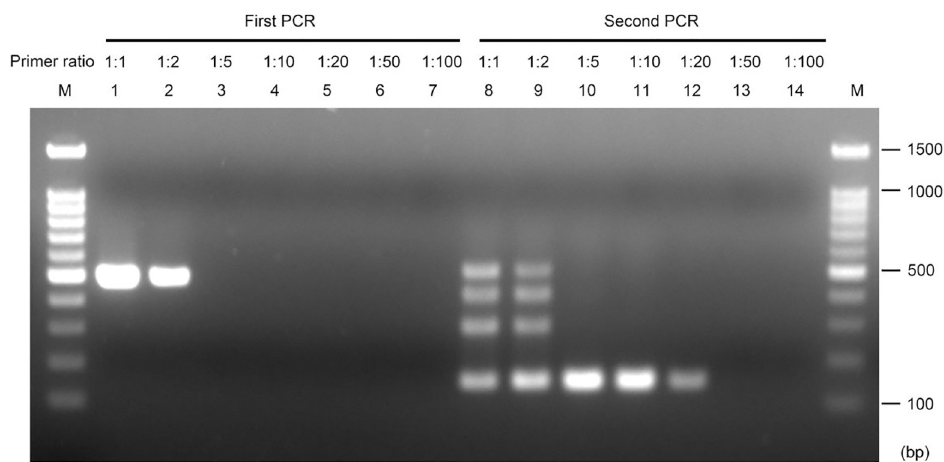
Fig 4. Optimization of the primer ratio for the nested PCR assay. Lanes 1–7, first PCR product; lanes 8–14, second PCR product. The nested PCR assay was performed using primers Col_nest-1F/Col_nest-1R for the first PCR, and Col_nest-2F/Col_nest-2R for the second PCR. Primer ratio represents the ratio of the concentrations of outer primers (first PCR) to inner primers (second PCR). The genomic DNA of C . siamense ML133 was used as the template. M, 100-bp ladder (Faith Biotechnology Co.,